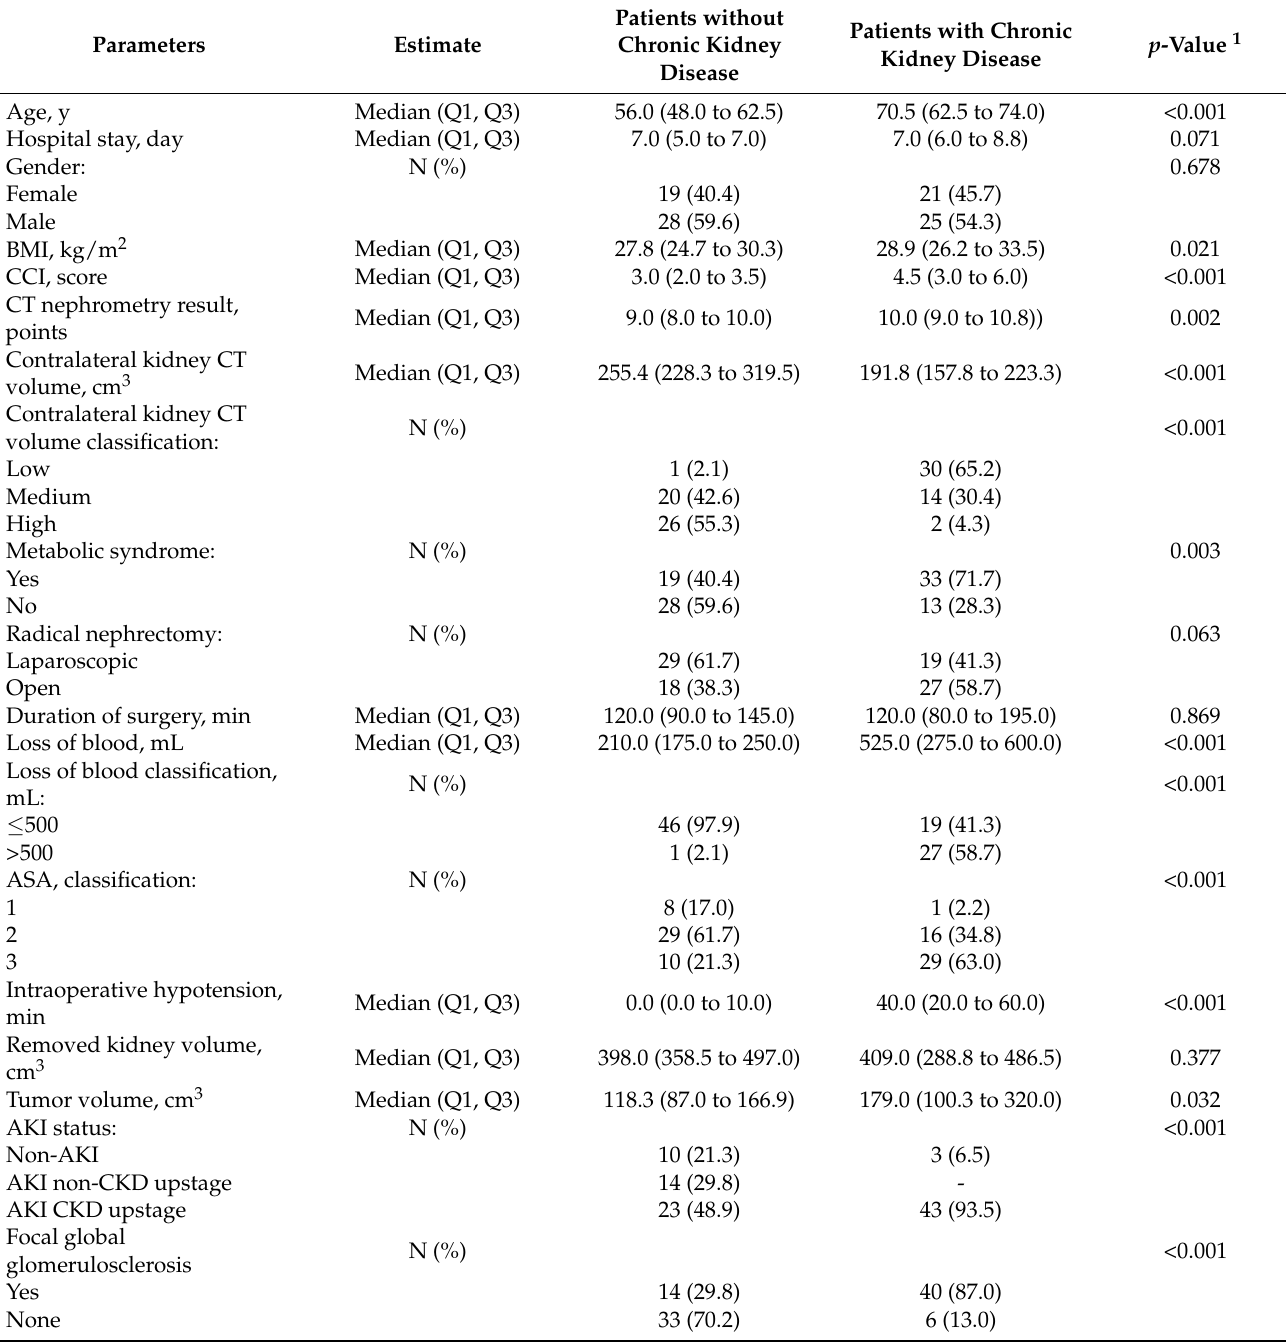
Table 1. Clinical and sociodemographic data of CKD and non-CKD study